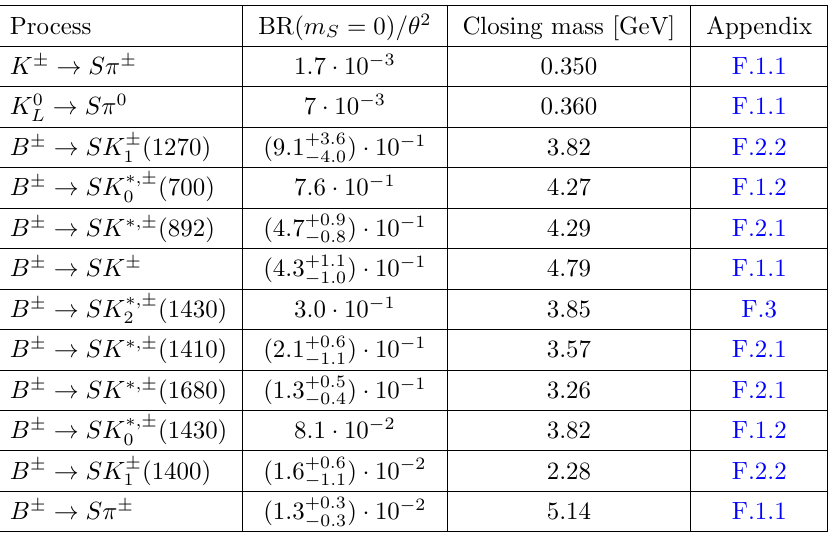
Table 3 . Properties of the main production channels of a scalar S from kaons and B mesons through the mixing with the Higgs boson. First column : decay channels; Second column : branching ratios